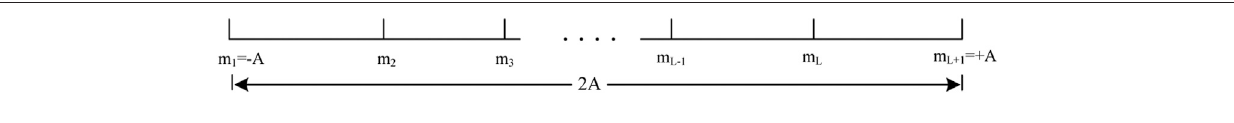
FIGURE 6 | Schematic diagram of the signal m ( t ) divided into L intervals.